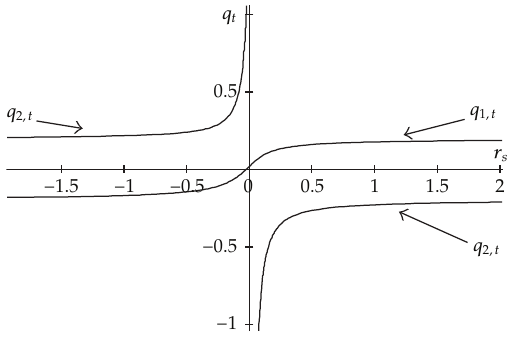
Figure 15: Zero-points curve of the equation f (cid:6) (cid:3) q t (cid:6) (cid:7)